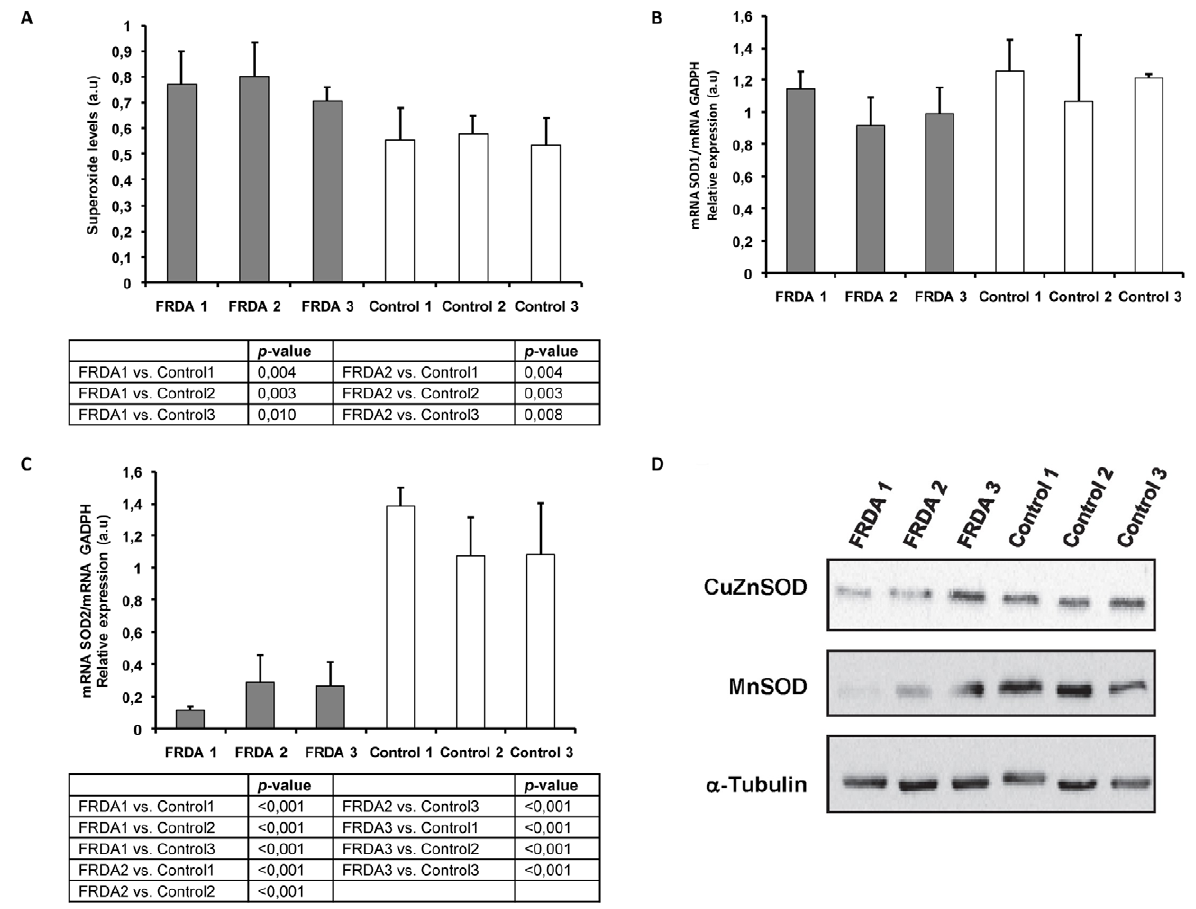
Figure 1. Analysis of the superoxide anion and the superoxide detoxifying enzymes in FRDA and control cells. A. Superoxide levels determined using dihydroethydium probe in FRDA fibroblasts from patients (FRDA 1, FRDA 2, and FRDA 3) and control cells (Control1, Control2, and Control3), results are shown as mean ( 6 SD) of 4–10 different experiments. B. Mean ( 6 SD) mRNA levels of CuZnSOD determined by RT-PCR by triplicate. C. Mean ( 6 SD) mRNA levels of MnSOD determined by RT-PCR by triplicate. D. CuZnSOD and MnSOD protein levels analyzed by western blot in FRDA and control cell lines.